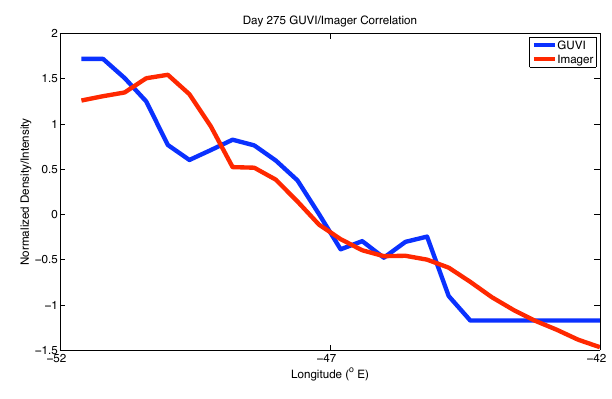
Fig. 7. Longitudinal correlation between the reconstructed GUVI electron density from 230-270 km and the latitude-integrated imager data from 2005 Day 275. Both datasets are normalized. The correlation coefficient between the two datasets is 0.95.